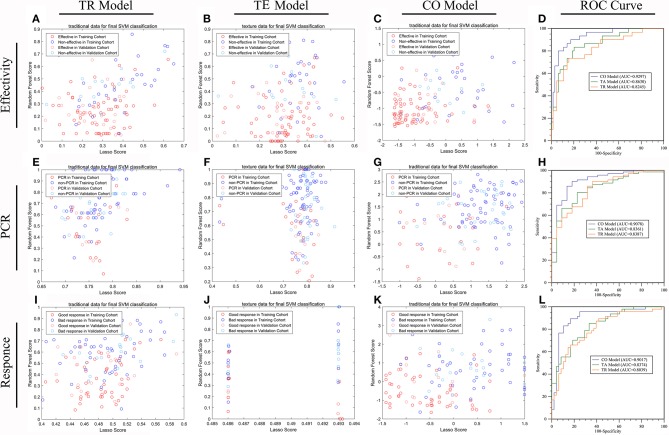
The efficiencies of machine learning models predicting treatment response in LARC patients receiving nCRT. The distribution of patients with down-staging disease or not (A–D), pCR or not (E–H), and good response or not (I–L), in TRC based model (model 6) (A,E,I), TE based model (model 3) (B,F,J) and the combined TRC and TE based model (Model 7) (C,G,K) were demonstrated by scatter plots. The ROC test (D,H,L) shows that the efficiency of model 7 was significantly higher than that of either model 6 or model 3 in all three missions (all P < 0.05). There is no significant difference in prediction efficiency between model 6 and model 3 in any of the three missions (all P > 0.05).